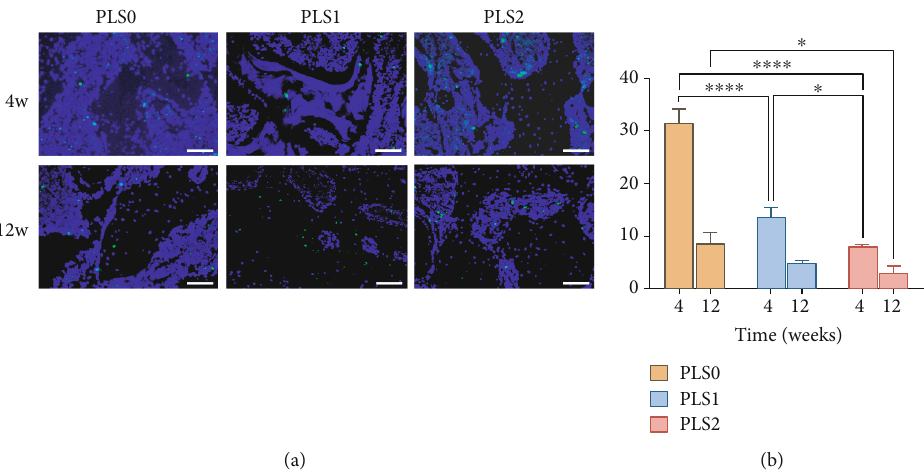
Figure 8: (a) Tunel staining conducted on the 4th week and 12th week after ONFH treatment (200x). (b) The apoptotic rate was calculated using the Tunel-staining